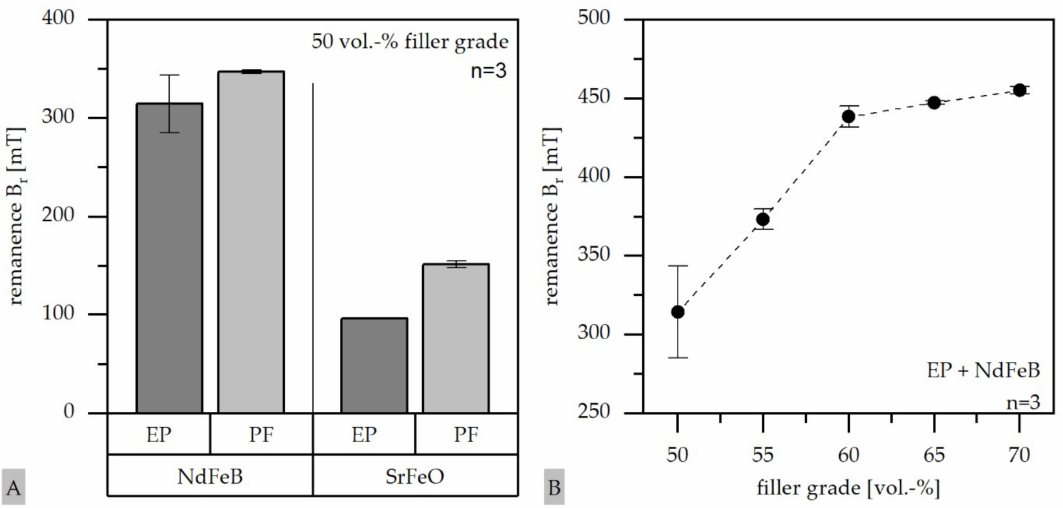
Figure 11. Magnetic properties relative to different matrix materials and fillers ( A ) and filler grades in EP with NdFeB ( B ) (SrFeO: strontium-ferrite-oxide; NdFeB: neodymium-iron-boron; PF: phenolic resin; EP: epoxy